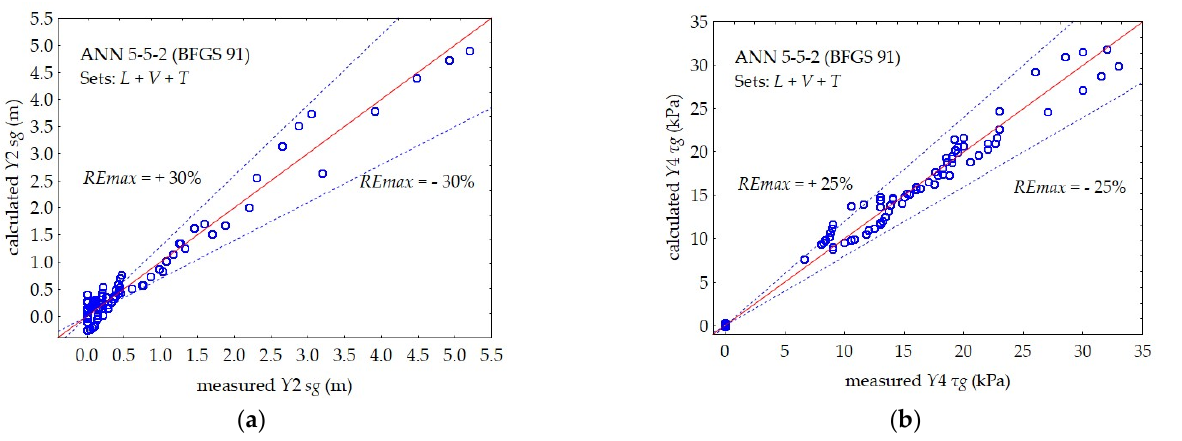
Figure 12. Comparison between the measured and calculated values by ANN 5–5–2 in subsets L + V + T for gyttja: ( a ) Y 2 sg , ( b ) Y 4 τ g .